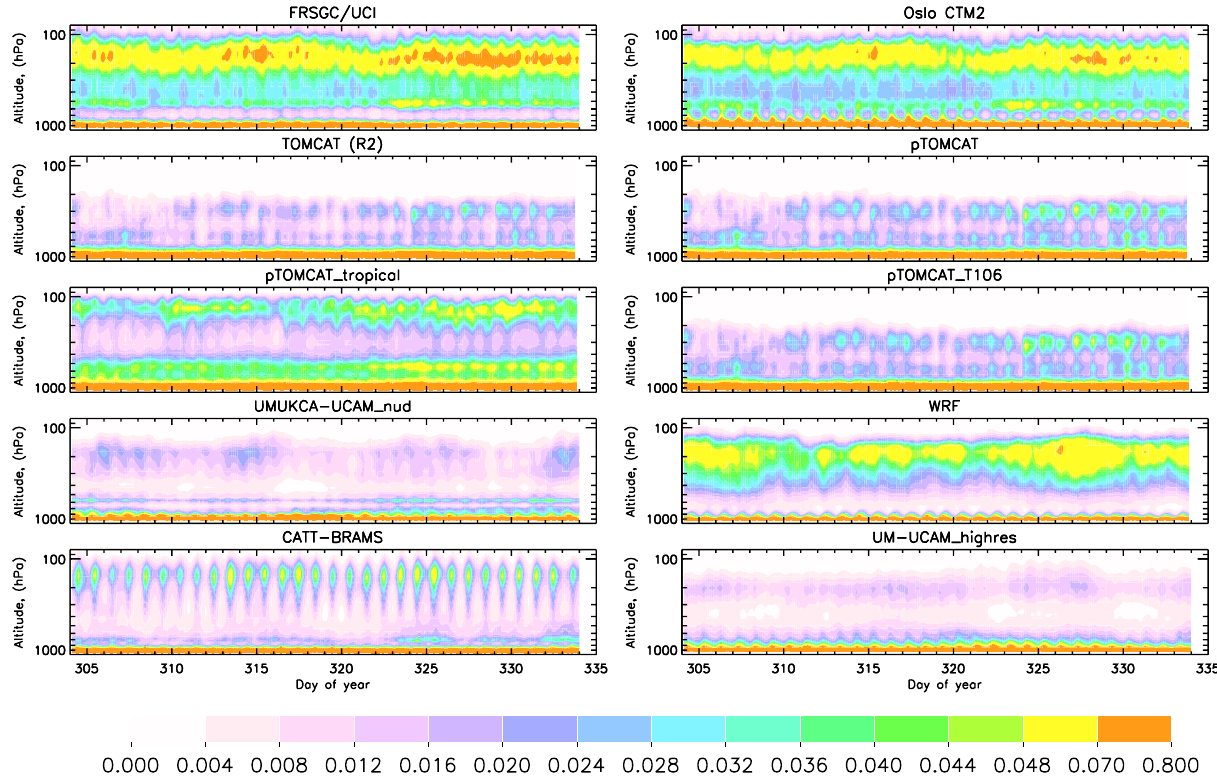
Fig. 3. Modelled profiles of mass mixing ratio as a function of time, for T6h, averaged over the Maritime Continent. The data runs from day 304 to 334, i.e. midnight on 1 November 2005 to midnight on 30 November